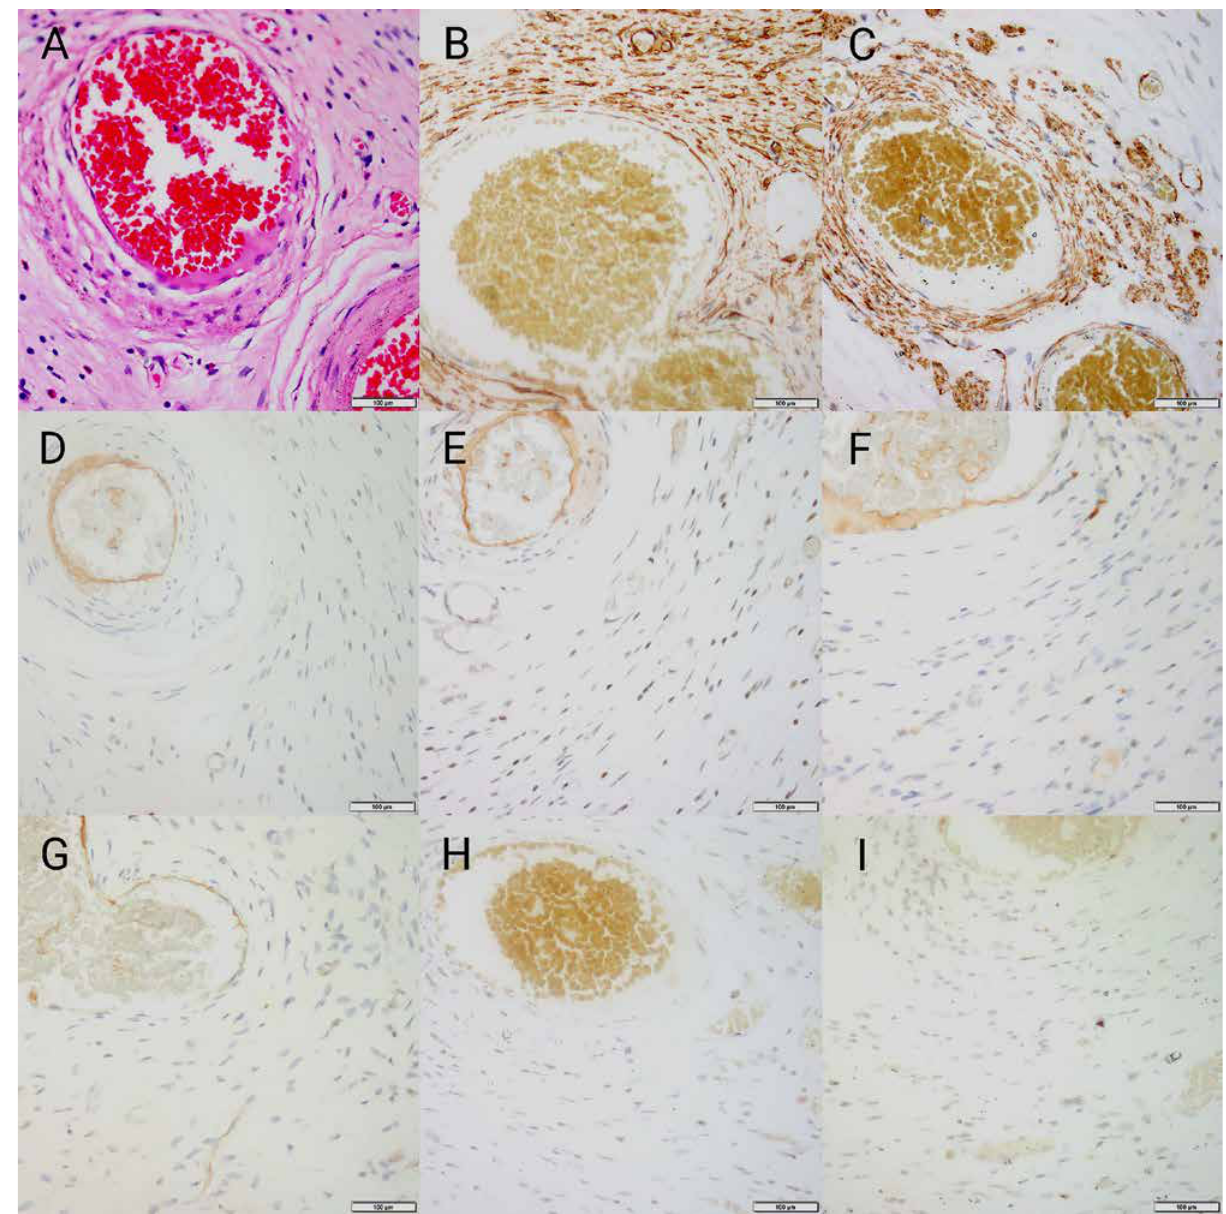
Figure 3: Histopathologic and immunohistochemical expression of pathological tissue. HE×400. The tumor cells demonstrated fusiform, vortex-like and onion-like hyperplasia around the blood vessels, there were some eosino- phils and lymphocytes, and a small number of plasma cells infiltrated the stroma. CD34. Immunohistochemical findings revealing spindle cells stained positive for CD34(tumor cells +) × 400. SMA. Immunohistochemical findings revealing spindle cells stained positive for SMA (tumor cells +) × 400. CD117. Immunohistochemical stain for CD117 shows negative in the lesional cells(tumor cells +) × 400. DOG-1. Immunohistochemical stain for DOG-1 shows negative in the lesional cells(tumor cells +) × 400. S100. Immunohistochemical stain for S100 shows negative in the lesional cells(tumor cells +) × 400. ALK. Immunohistochemical stain for ALK shows negative in the lesional cells(tumor cells +) × 400. P53. The P53 labeling index was 1%(tumor cells +) × 400. Ki-67. The Ki-67 labeling index was 5% in the spindle cells(tumor cells +) × 400. HE= Hematoxylin-eosin staining, SMA= SmoothMuscle